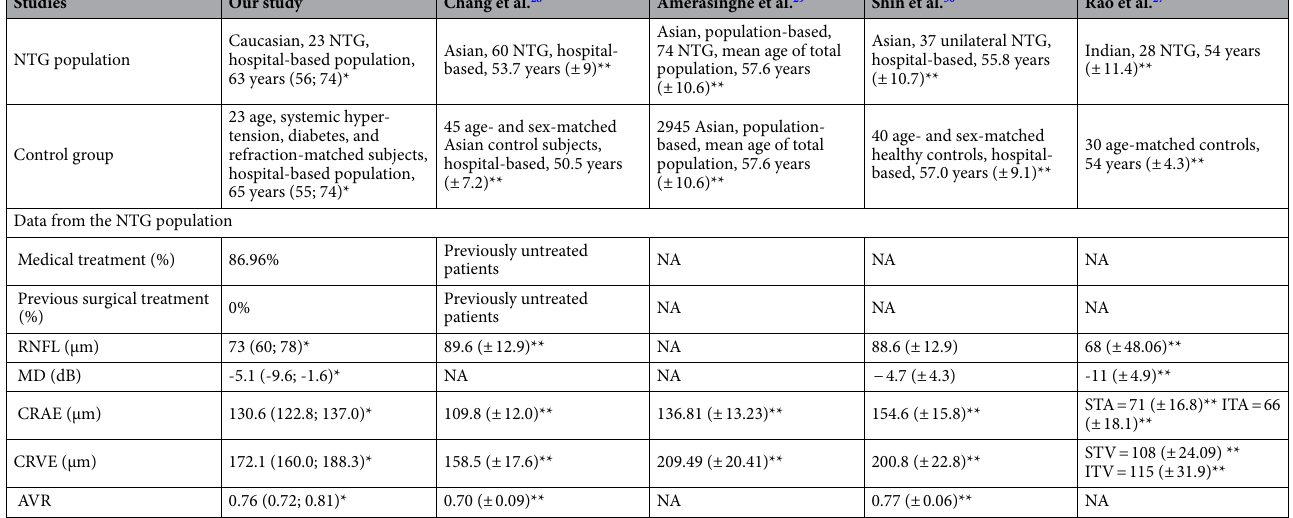
Table 4. Primary studies reporting on retinal vessel parameters for normal tension glaucoma (NTG). Data are expressed as median (interquartile range (25–75th percentiles))* and mean (standard deviation)**